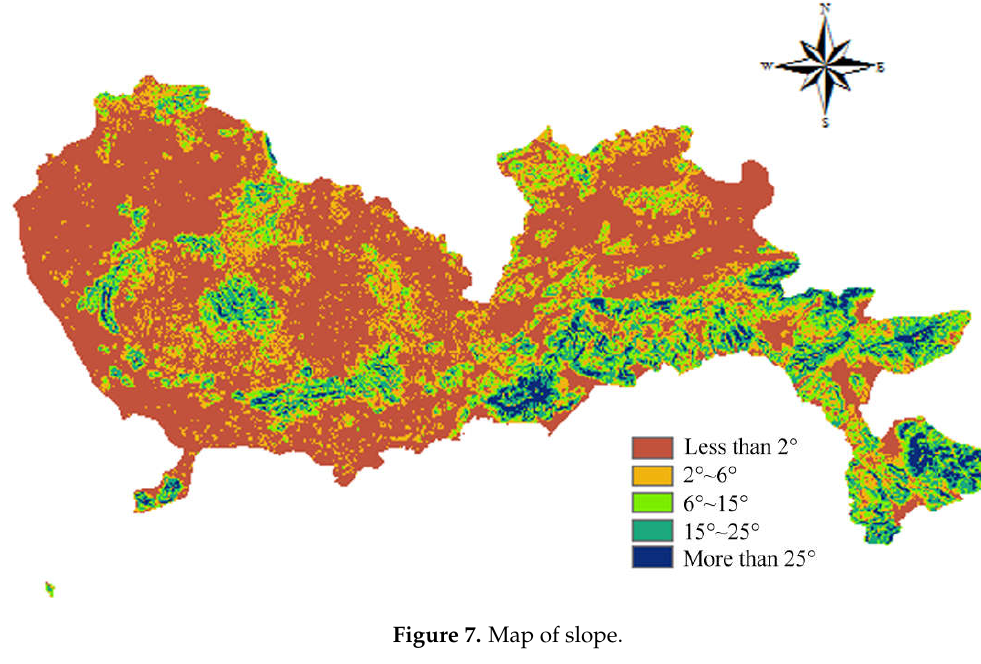
Figure 7. Map of slope.